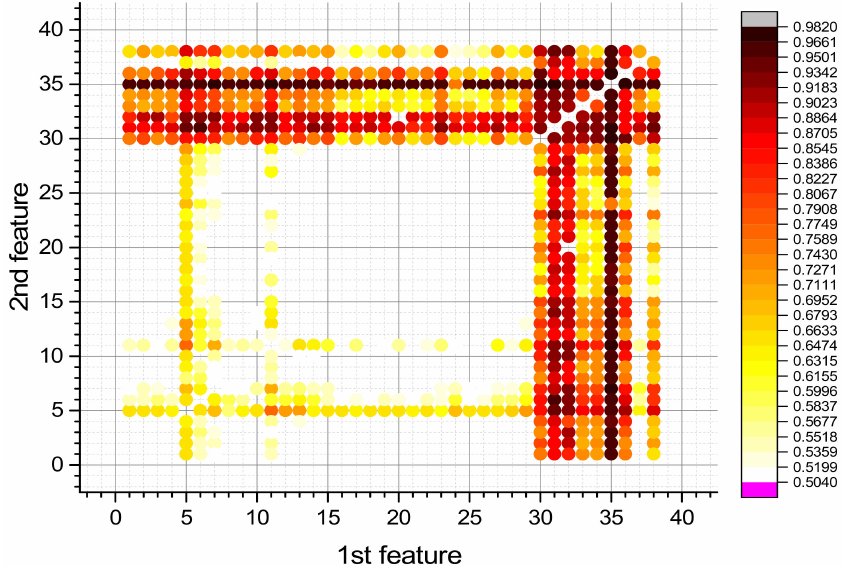
Figure 12. Feature pairs with the highest F1 2 value that was found with the HGB classifier for detection of surviving and non-surviving COVID-19